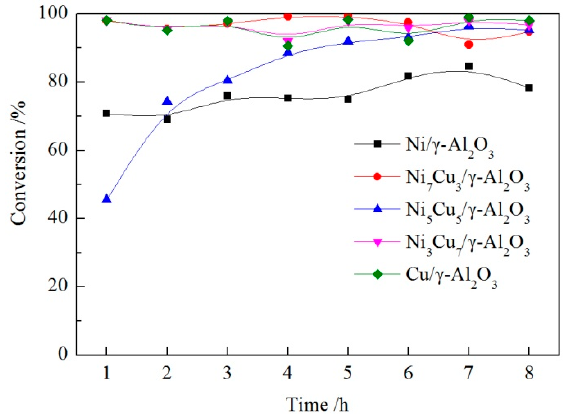
Figure 6. Conversion of benzofuran (BF) over Ni x Cu (10 − x ) / γ -Al 2 O 3 catalysts. (Reaction conditions: T = 300 °C, p = 3.0 MPa, WHSV = 4.0 h − 1 , and H 2 /oil = 500 (V/V)).